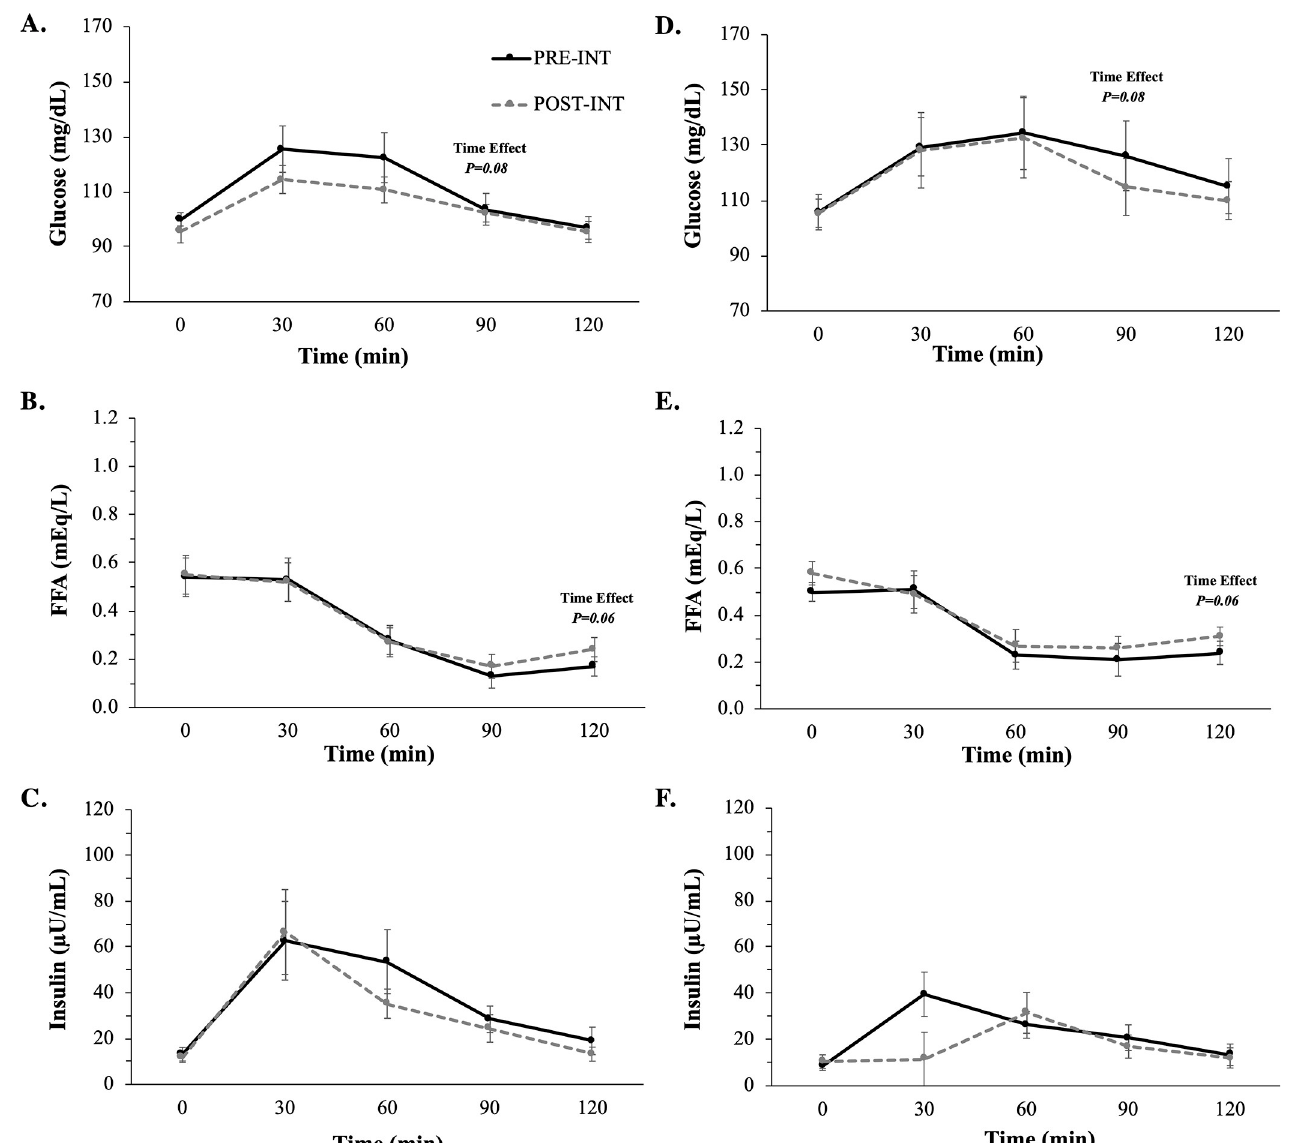
Fig 2. The effect of SC ( A-C ) and EX+SC ( D-F ) on mixed meal tolerance test glucose, free fatty acid (FFA), and insulin curves. Data are means ± SEM. There was a trend for a time effect for 90 minute glucose ( P = 0.08) and 120 minute FFA ( P = 0.06). Conversions: Glucose, 1.00 mmol/L = 18.01 mg/dL; FFA 1.00 mEq/L = 1.00 mmol/L; Insulin, 1.00 μ U/mL = 6.95 pmol/L.